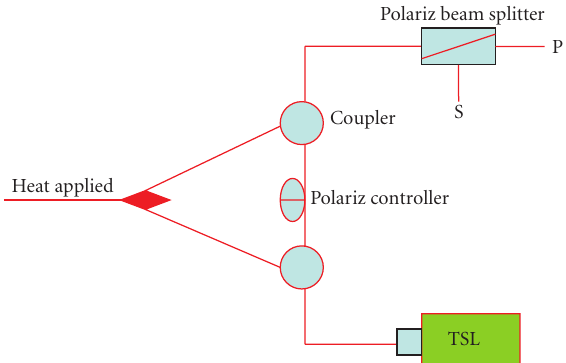
Figure 3: Optical network applied for polarization diverse mea- surement of Rayleigh